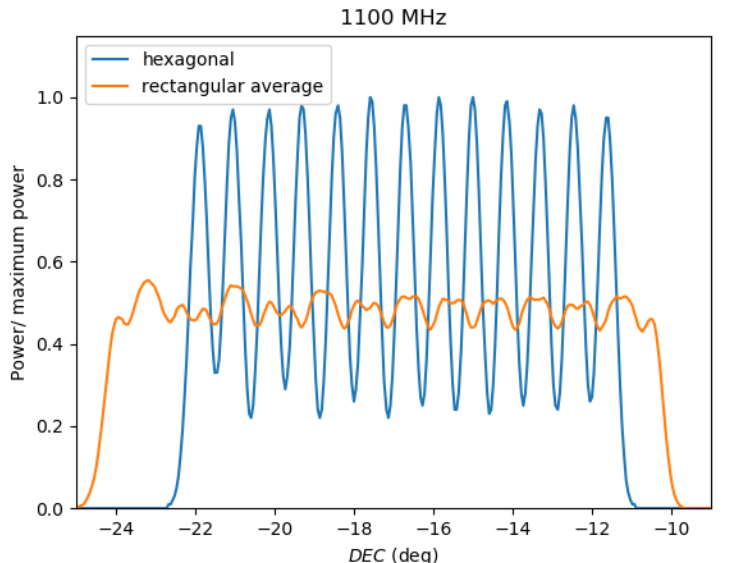
Figure 6. Combined beam response for rectangular arrangement (columns 2 and 3, left to right) and hexagonal arrangement (columns 4 and 5, left to right) shown in figure 5 at 1100 MHz (Abdalla et al. 2021).